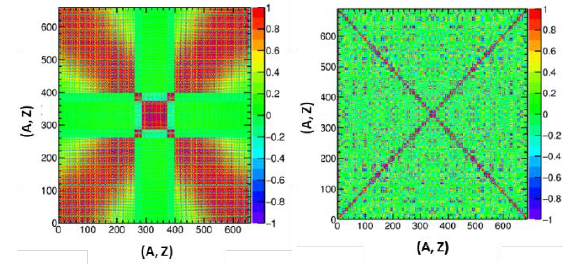
Fig. 7. The correlation matrices of the pre-neutron charge distribution based on Wahl-like approach (left) and direct-Z p approach (right). The axes represent the isotope indexes.